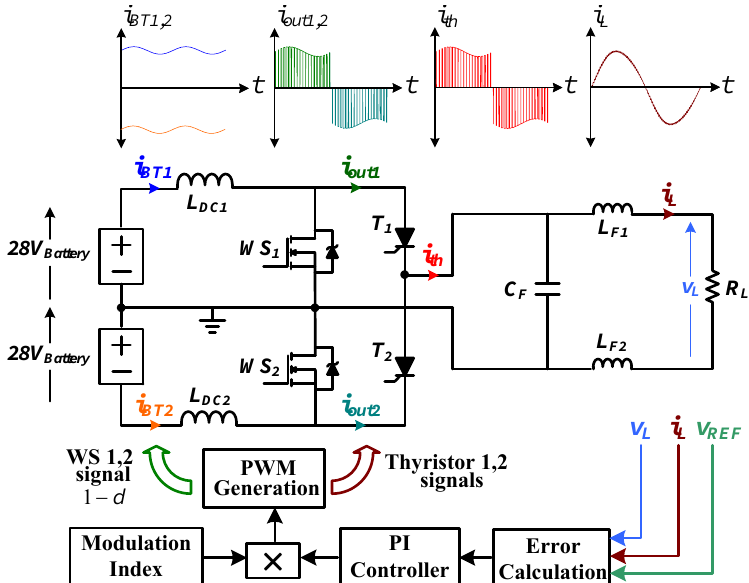
Figure 3. Current–source inverter circuit with control and current waveforms.